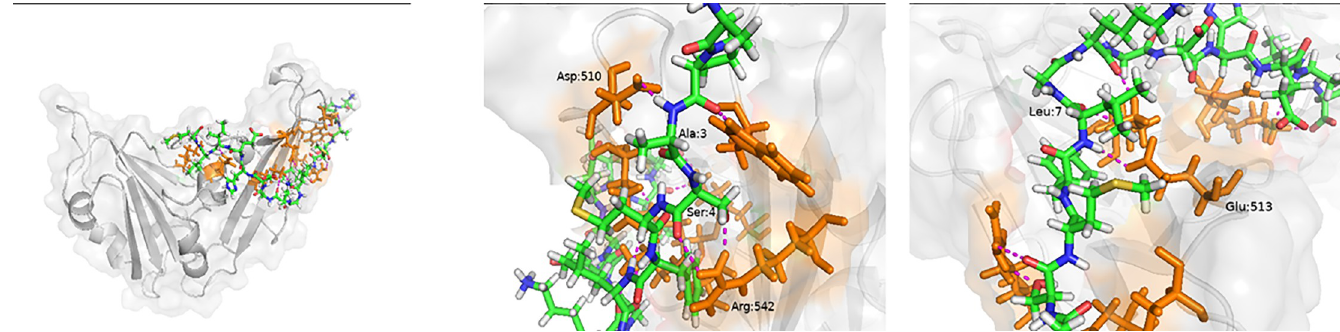
Fig 8. (a) Peptide 7 –MERS-CoV RBD complex. The Peptide 7 residues (blue, green and white). The MERS-CoV RBD is shown in grey and the residues interacting with Peptide 7 are shown in orange. (b) Interaction between MERS-CoV RBD Asp:510 and Peptide 7 Ala:3 and MERS-CoV RBD Arg:542 and Peptide 7 Ser:4. (c) Interaction between MERS-CoV RBD Glu:513 and Peptide 7 Leu:7. https://doi.org/10.1371/journal.pone.0251913.g008 Peptide 7 sequence was formed by creating a consensus sequence from three different pep- tides that bind individually to the three different RBDs and hence the interactions between the Peptide 7 and RBDs differ between them not only due to the difference in the peptides used to